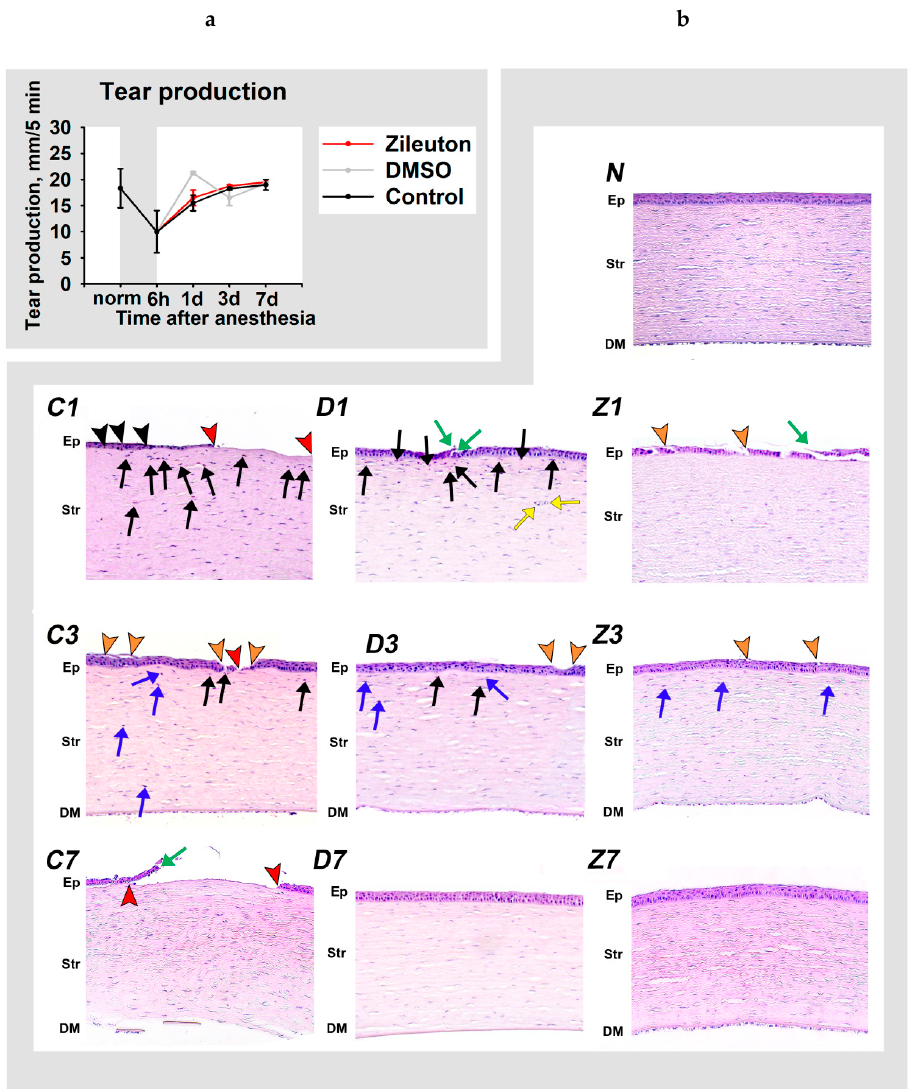
Figure 5. Dynamic changes in tear secretion and corneal morphology in DES in the course of anti-inflammatory therapy. The animals were exposed to general anesthesia for 6 h (shown as gray box) and subsequently received instillations of the eye drops containing 50% DMSO (D1, D3, D7) or 50% DMSO with 0.5% zileuton (Z1, Z3, Z7) for 7 days. ( a ) The results of standardized Schirmer’s tests performed at 6th hour, 1st day, 3rd day or 7th day after the exposure. ( b ) Representative microscopic images of hematoxylin and eosin-stained cross-sections of the corneas at 1st (D1, Z1), 3rd (D3, Z3) and 7th (D7, Z7) day after exposure. The image of the normal cornea is also presented (N). Stromal denudation (complete absence of the corneal epithelium) areas (red arrowheads), loci of desquamation/destruction of the epithelial layer (orange arrowheads), and sites of reepithelialization (green arrows) are indicated. The inflammatory changes include granulocytic infiltration in the corneal epithelium (intraepithelial granulocytes; black arrowheads) and stroma (black arrows), neovascularization (yellow arrows), and postinflammatory signs of regeneration (activation of stromal keratocytes) at the ex-sites of the infiltration (blue arrows). Ep: epithelium; Str: stroma; DM: Descemet’s membrane and endothelium. Hematoxylin and eosin staining, magnification 200×. The central areas of the cornea are presented. Gaps, cracks and folds of preparations are of an artificial origin.